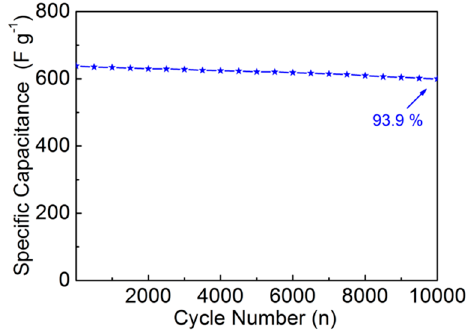
Figure 5. Long-term cycling performance of the MnFe 2 O 4 @C electrode.